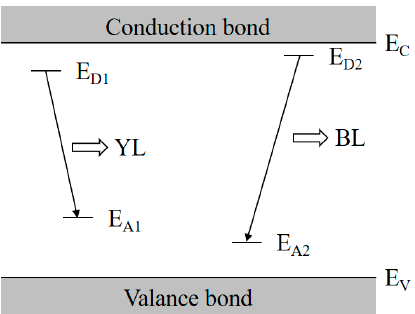
Figure 7. Schematic diagram of the proposed transition model on the YL and BL of u-GaN samples. where E D 1 is mainly contributed by Si donor. Figure 6. Dependences of the intensity ratio of BL to YL of n-GaN samples A0–A3 on the Si concentration. The blue line is used to guide the eye.